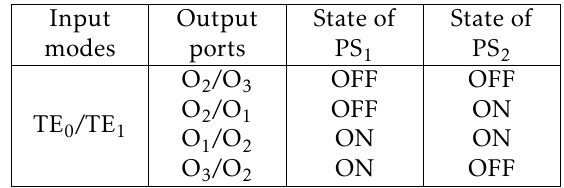
Figure 4. Phase difference between two branches of the Y-junction as a function of : a) the effective indices, N ; b) the PS width, W . e ff 1 PS 1 Table 1. Control states to two PSs to realize the switching functionalities of the device for all configurations.